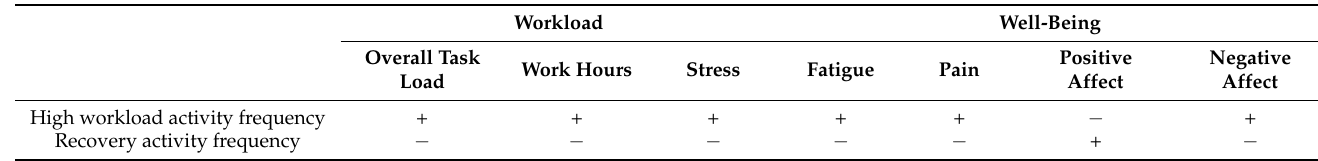
Table 1. Hypothesized intra-person correlations between relative activity frequency and measures of workload and well-being.